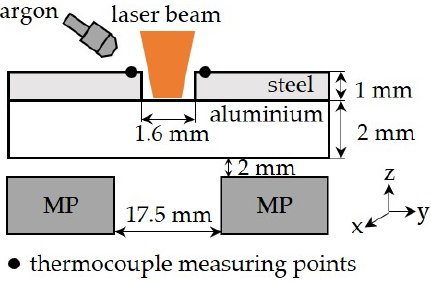
Figure 9. Schematic illustration of the experimental setup.